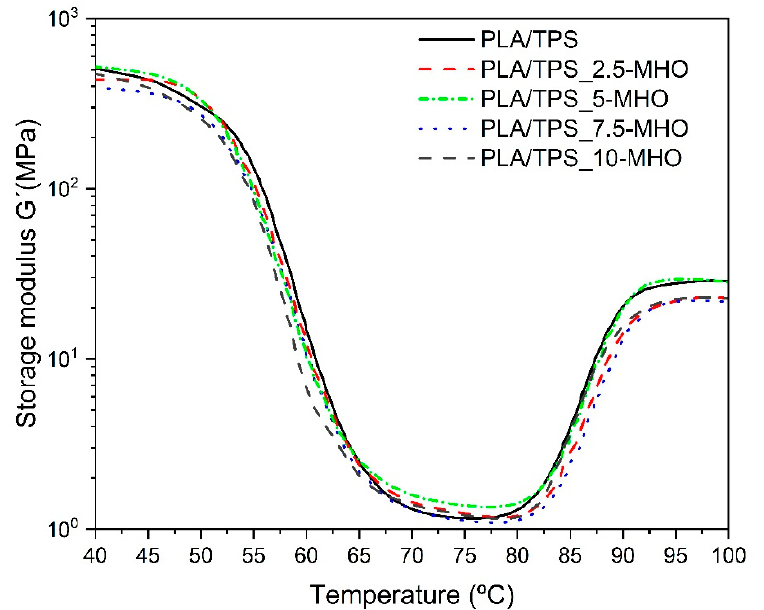
Figure 6. Storage module for of PLA/TPS blend unplasticized and plasticized with different amounts of MHO content as a function of temperature.